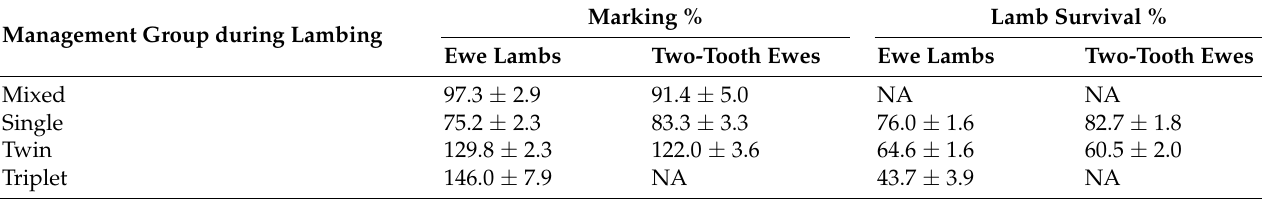
Table 6. Predicted means ± standard error for the marking (%) and lamb survival (%) accord- ing to ewe management group during lambing for non-Merino ewe lambs and maiden Merino two-tooth